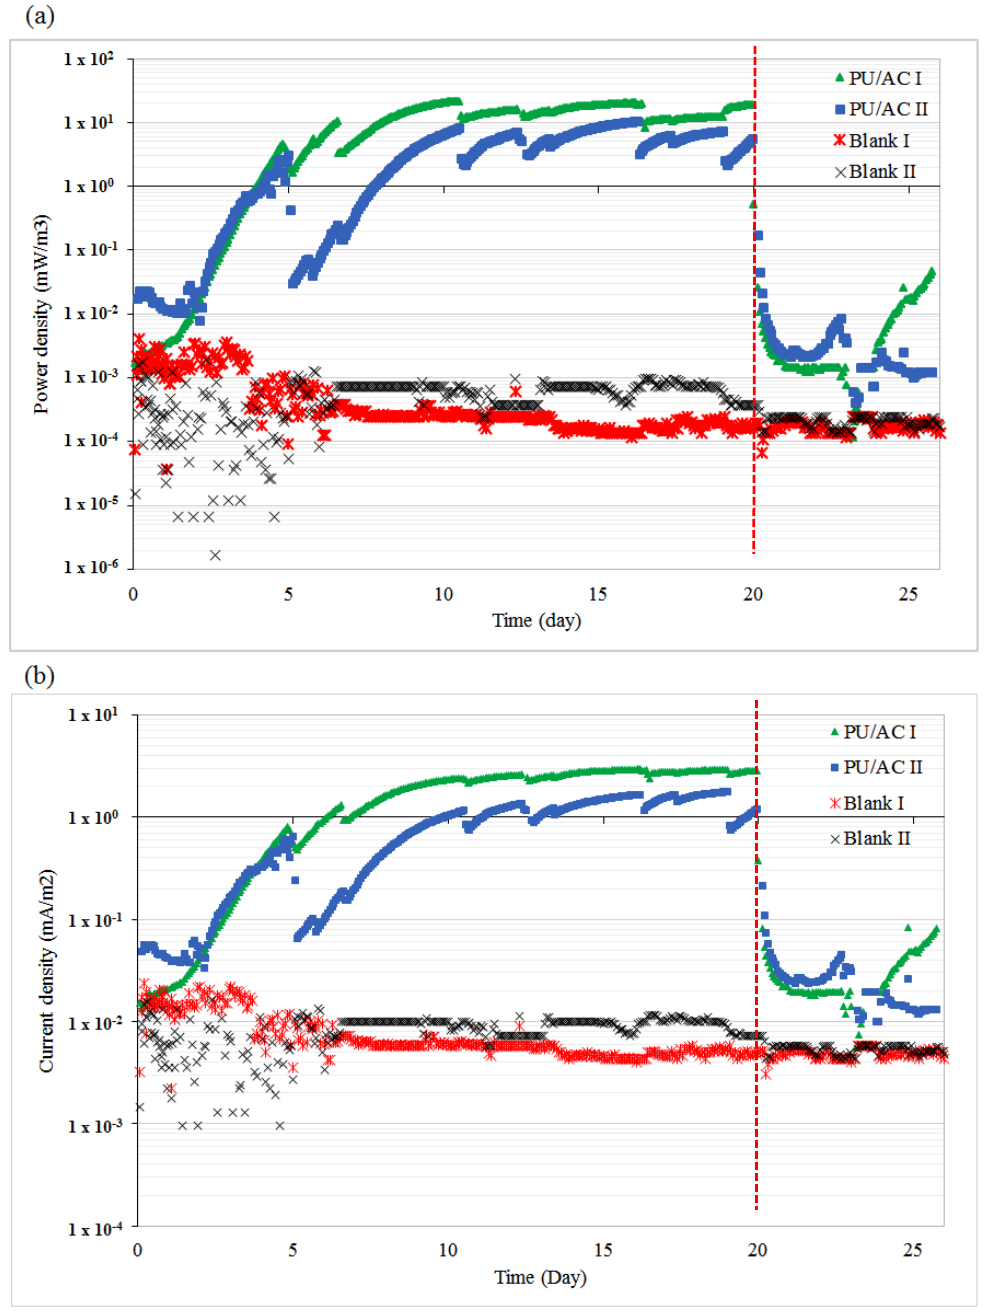
Figure 6. PU / AC electrode is able to deliver electricity in an MFC. ( a ) Power densities obtained in PU / AC bioanodes and blanks; the anode compartment volume was used for normalization. ( b )